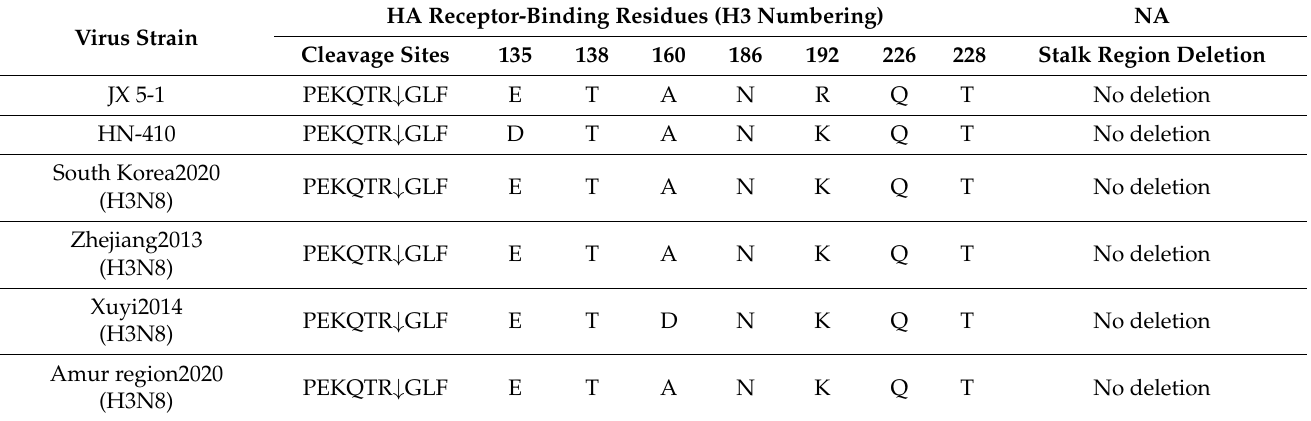
Table 2. Comparison of the hemagglutinin (HA) receptor-binding sites and neuraminidase (NA) gene segments of the novel avian H3N8 isolate and those of high related avian H3N8 isolates. HA Receptor-Binding Residues (H3 Numbering) NA Virus Strain Cleavage Sites 135 138